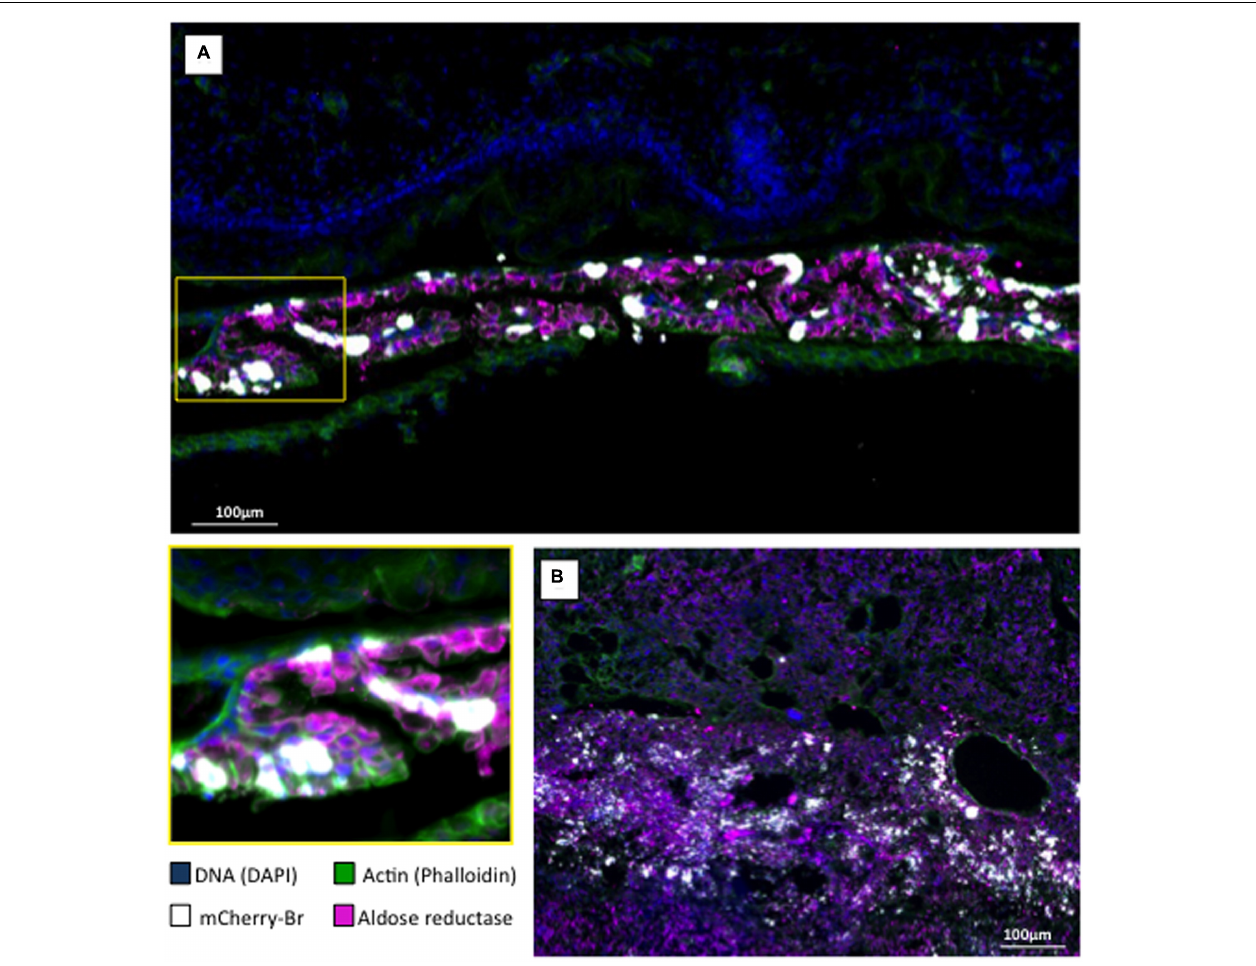
FIGURE 8 | Aldose reductase localization in B. abortus infected murine conceptus. Pregnant mice were intraperitoneally infected at post-conception day 6 with 10 5 CFU of a B. abortus mCherry (mCherry-Br; white color). Conceptus were obtained at post-conception day 15 and stained for DNA (DAPI/blue) and actin (phalloidin/green). (A) Aldose reductase immunostaining (purple) of the trophoblastic layer surrounding the fetus (the area in the yellow square corresponds to the lower left panel of the Figure). (B) Aldose reductase immunostaining (purple) of the placenta at the level of the decidua